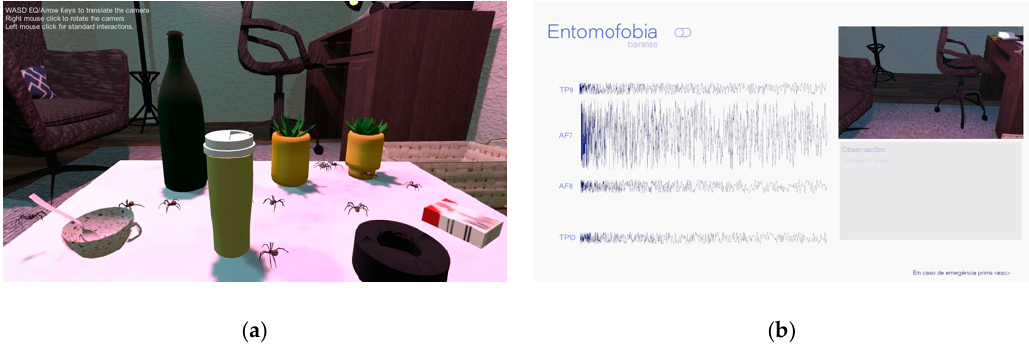
Figure 1. ( a ) Virtual environment with spiders; ( b ) Screen used by the therapist to read the electroencephalogram.